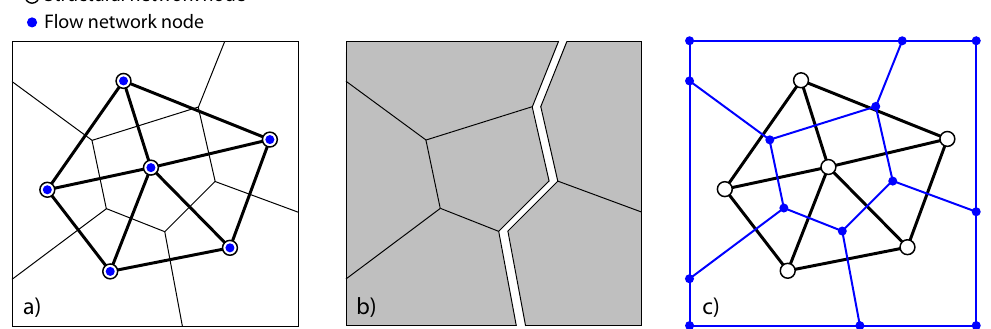
Figure 1. Network models for coupled problems: ( a ) common approach in which the structural and transport network nodes are coincident. Both structural and transport elements are on the Delaunay edges; ( b ) simulated crack in structural network; and ( c ) improved approach in which transport elements are on the Voronoi edges and therefore aligned with potential cracks.